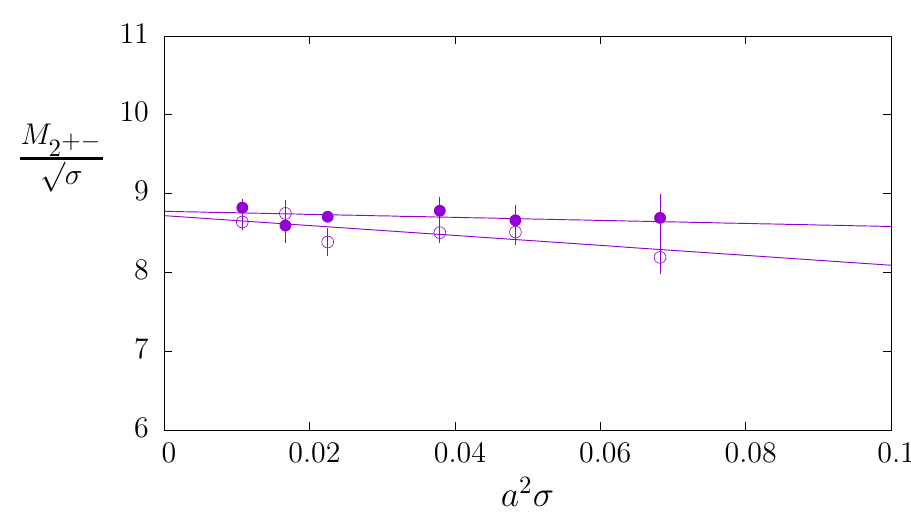
Figure 19 . Continuum extrapolation of the masses of the lightest J PC = 2 + − glueball, composed of the lightest (doubly degenerate) E + − state, • , and the first excited (triply degenerate) T 2 + − state, ◦ .